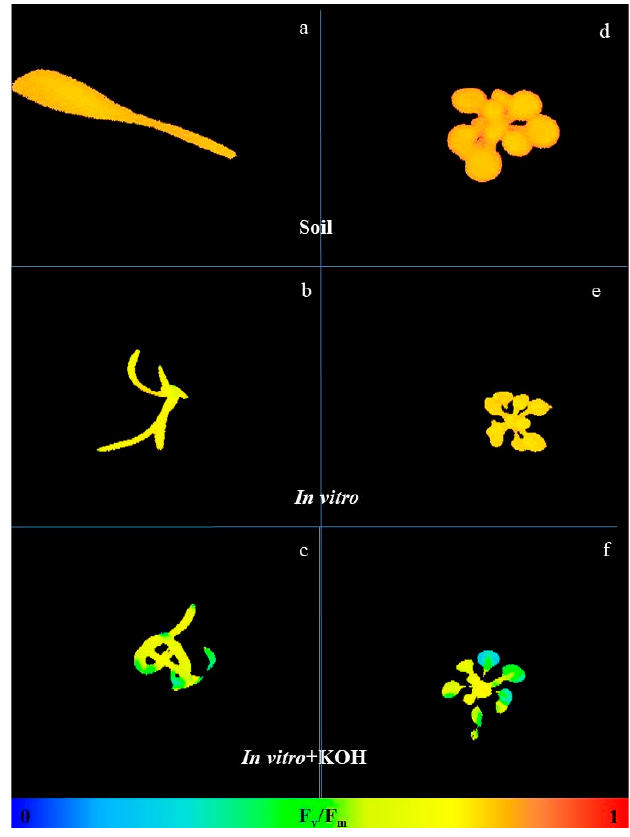
Figure 7. Image of F v /F m of lilies and Arabidopsis grown ex vitro ( a , d ), in vitro with 3% sucrose ( b , e ), and in vitro with 3% sucrose in a CO 2 -poor environment ( c , f ).